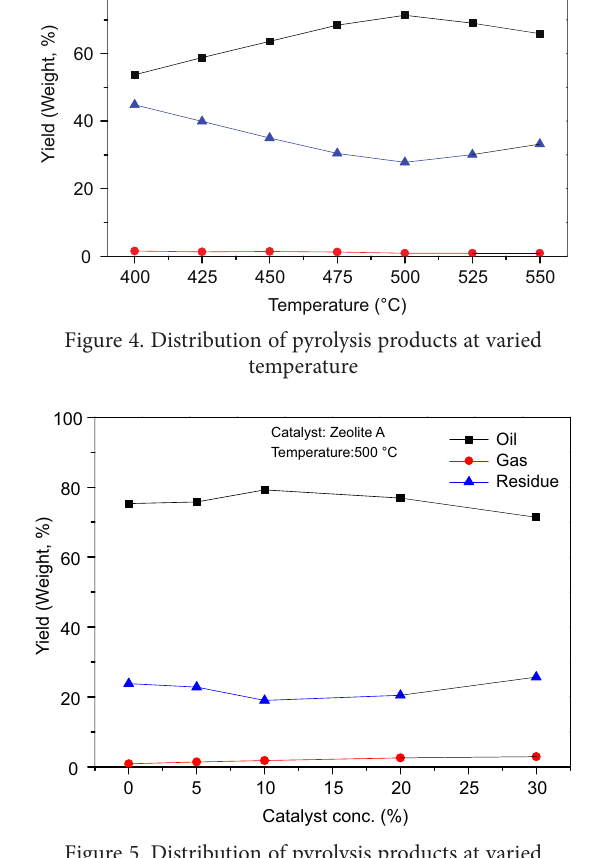
Figure 5. Distribution of pyrolysis products at varied catalyst